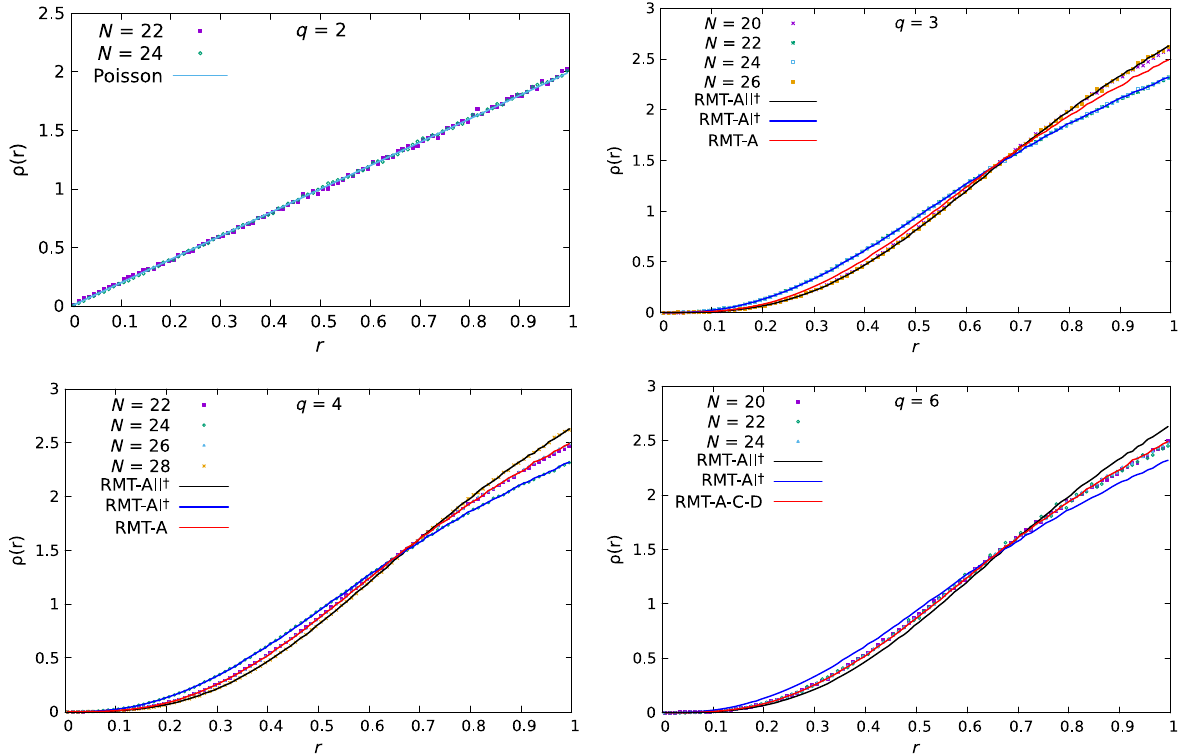
FIG. 8. Radial density of the complex spacing ratio related to the eigenvalues of the nHSYK Hamiltonian Eq. (17) for different values of N and q . We see agreement with the predictions of Table II in all